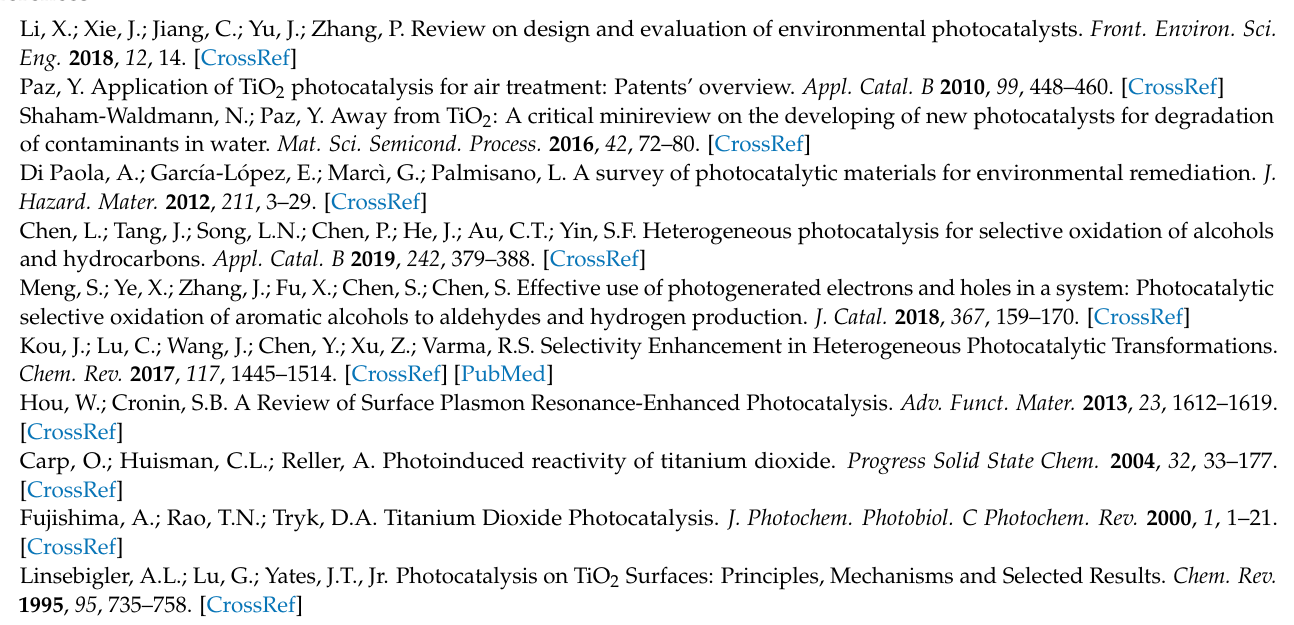
energy regions, Figure S3: High resolution XPS spectra of Au/TiO 2 in O 1s, Ti 2p and Au 4f binding energy regions, Figure S4: High resolution XPS spectra of Pt/TiO 2 in O 1s, Ti 2p and Pt 4f binding energy regions, Figure S5: Comparative XRD difraction patterns of simple and